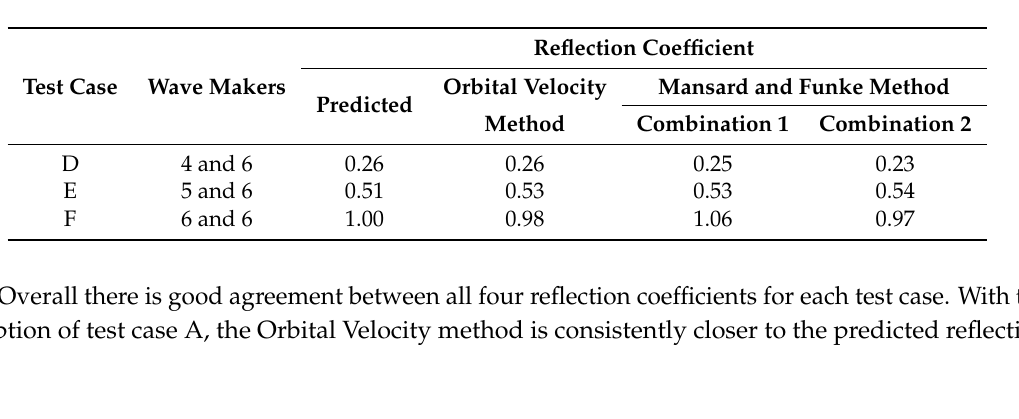
Table 6. Reflection coefficients using different methods from the intermediate water (0.3m)